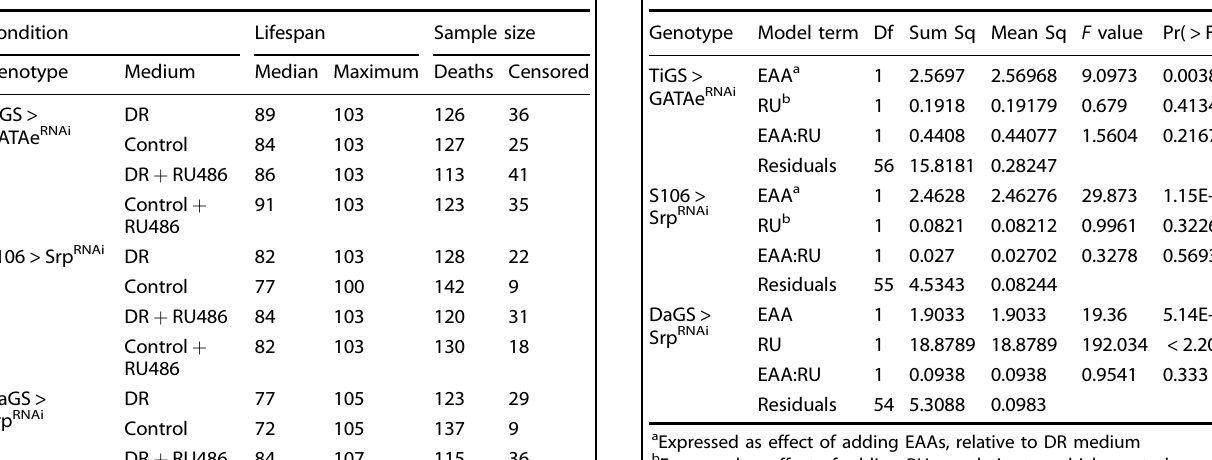
Table 4. Median and maximum survival, DR × GATA RNAi lifespan studies